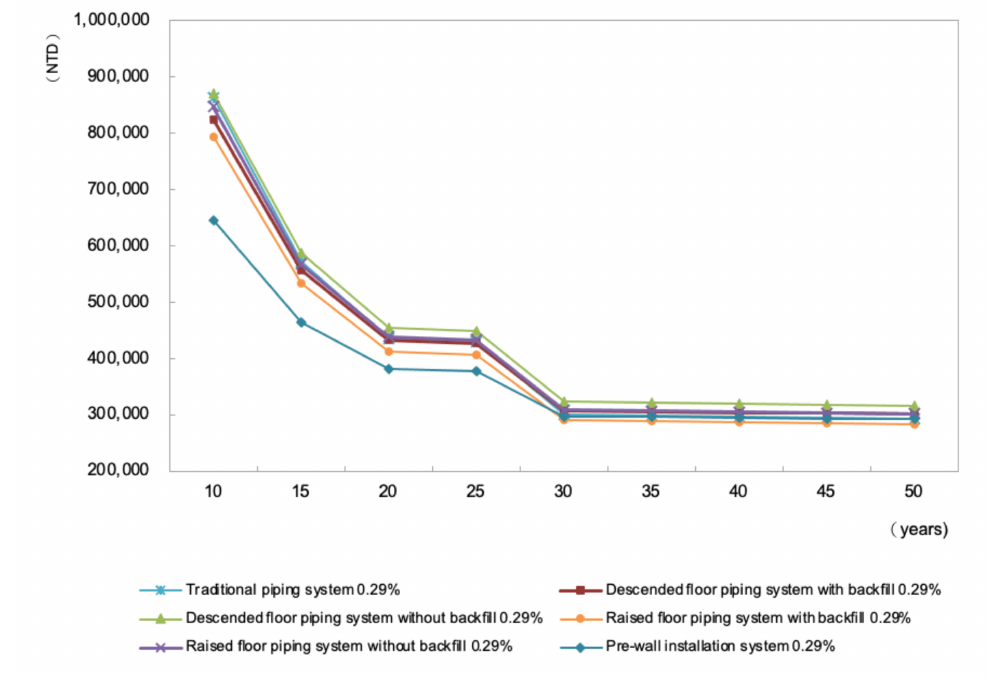
Figure 5. Life cycle costs for the complete replacement of pipelines in the four types of bathroom piping systems with discount rate of